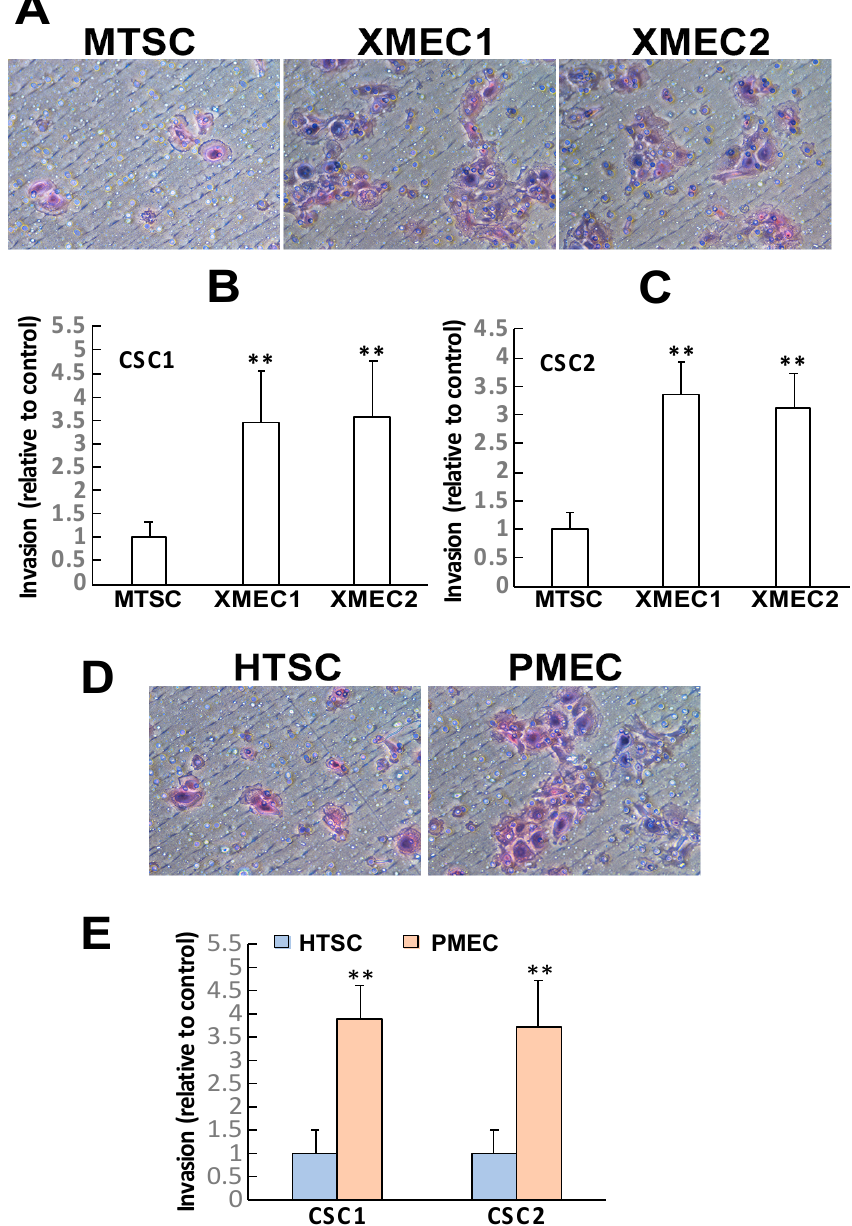
Figure 2. PTC tumor stromal cells enhanced CSC invasiveness. ( A ) Patient-derived xenograft tumor stromal cells increased CSC1 invasive activities in Boyden chamber invasion assays. ( B , C ) Quantitative analyses showed different xenograft tumor stromal cells having the capacity to enhance both CSC1 and CSC2 cell invasion. ( D ) Patient primary tumor stromal cells increased CSC1 cell invasive activities. ( E ) Quantitative analyses revealed patient primary tumor stromal cells having the capacity to enhance both CSC1 and CSC2 cell invasion. Data are representative of at least three independent experiments and shown as mean ± SEM. Mouse normal thyroid stromal cell culture (MTSC), xenograft tumor microenvironment stromal cell culture (XMEC), patient non-tumor thyroid stromal cell culture (HTSC), patient primary tumor microenvironment stromal cell culture (PMEC); ** p < 0.01. Scale bars: 100 µm.